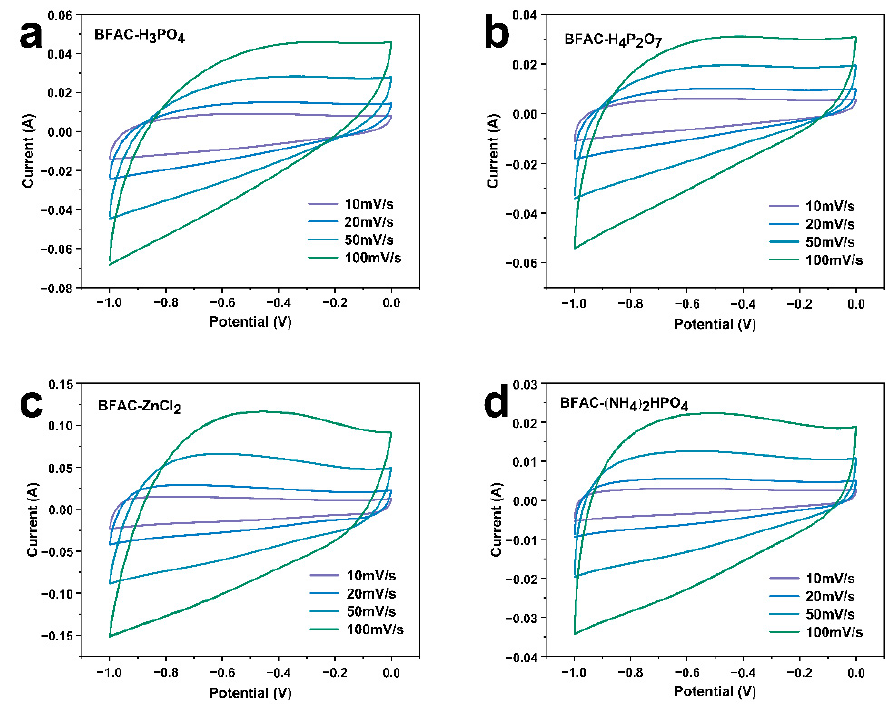
Figure 9. CV comparison of BFACs at from 10 to 100 mV/s scan rates ( a ) BFAC-H 3 PO 4 , ( b ) BFAC- H 4 P 2 O 7 , ( c ) BFAC-ZnCl 2 , ( d ) (NH 4 ) 2 HPO 4 H 4 P 2 O 7 , ( c ) BFAC-ZnCl 2 , ( d ) (NH 4 ) 2 HPO 4 .